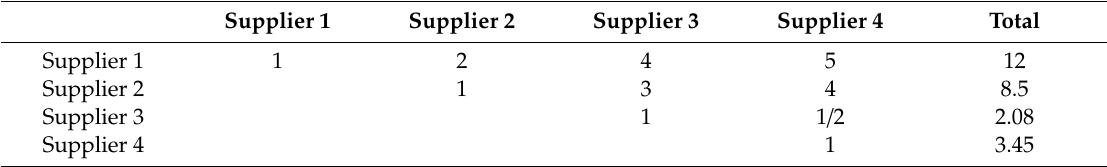
Table 5. The results of pairwise comparison for supplier alternatives with regard to cost criterion.